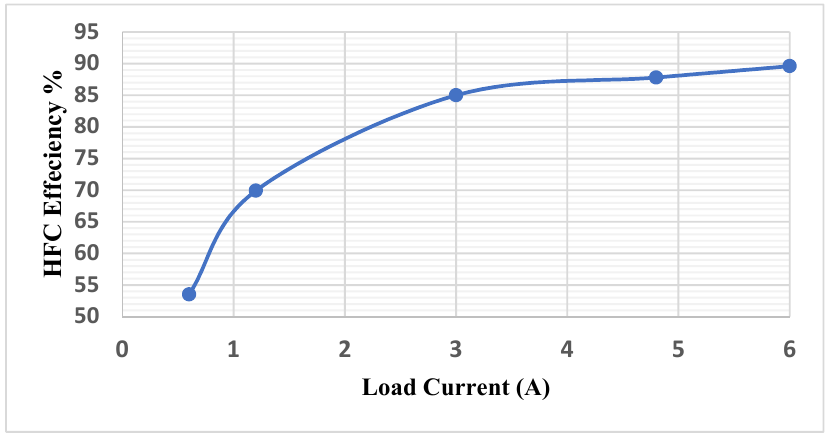
Figure 11. HFC converter efficiency under different load conditions.